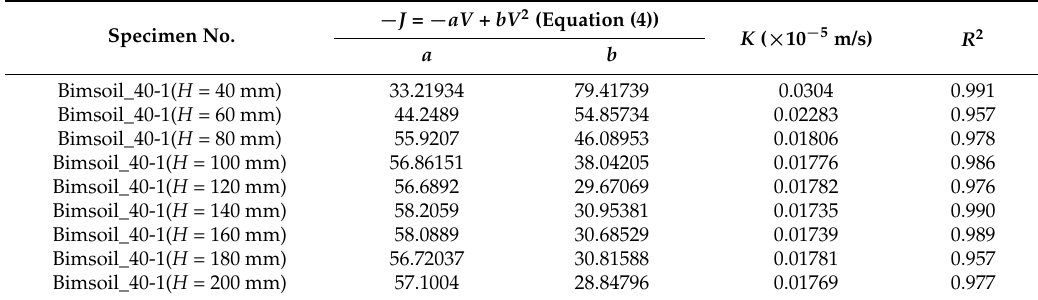
Table 4. The non-Darcy’s flow equations for typical specimens with rock block percentage of 40%, using Forchheimer